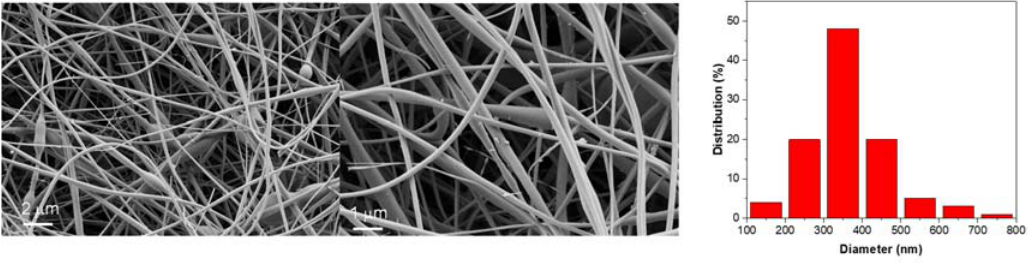
Figure 2. SEM images of SiNF at di ff erent magnifications and thickness distribution of